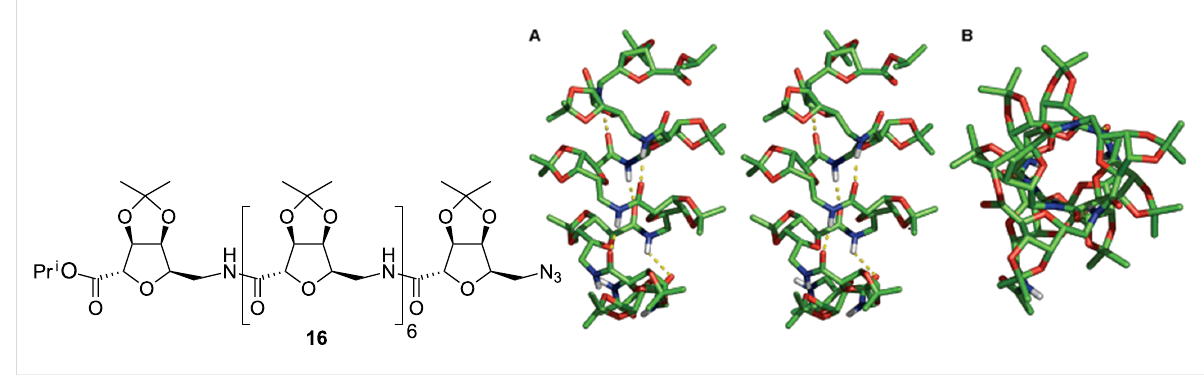
Figure 6: (A) Stereoview of the minimized structure of compound 16 (produced by a 500 ps simulation) that most satisfies the 27 NOE derived dis- tance constraints. (B) View looking from C to N terminus. Hydrogen bonds are indicated by dotted lines.